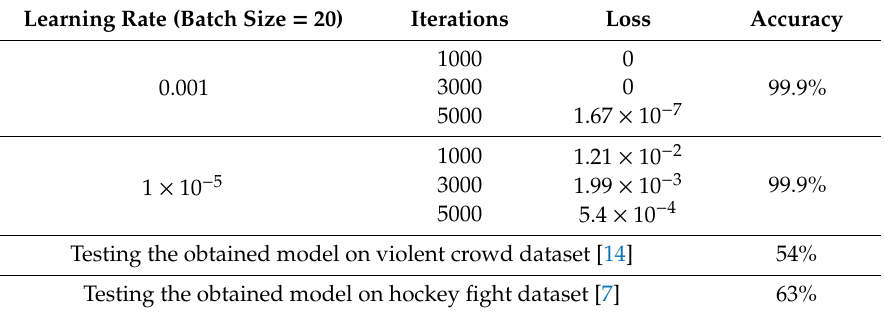
Table 4. Classification accuracies of the proposed method on violence in movies dataset